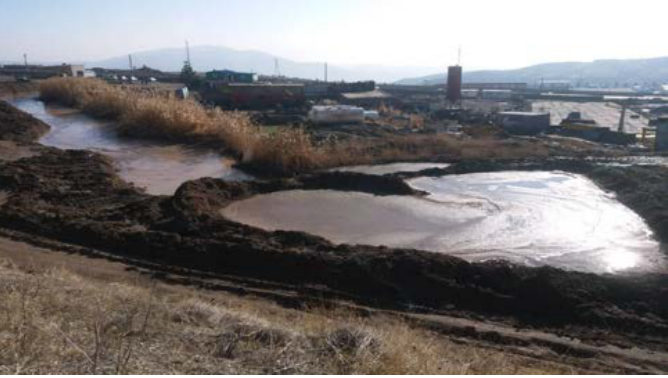
Fig. 4: The sight of the unmanaged sand washing mud in the study area